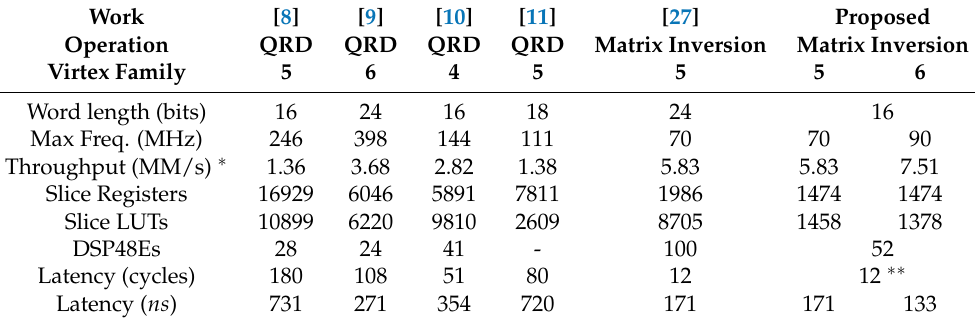
Table 2. Resource utilization for 4 × 4 matrix computations.